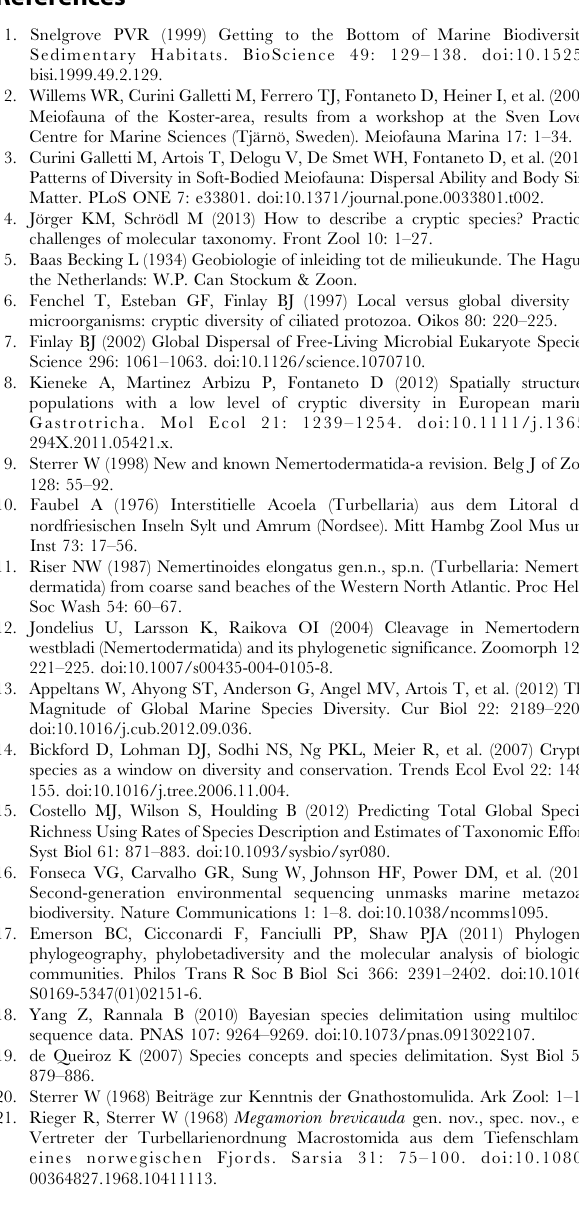
Table S4 Averaged pairwise distances across the His- tone 3 gene dataset. For Sterreria variabilis n.sp. pairwise distances are also given for the four subdivisions within the